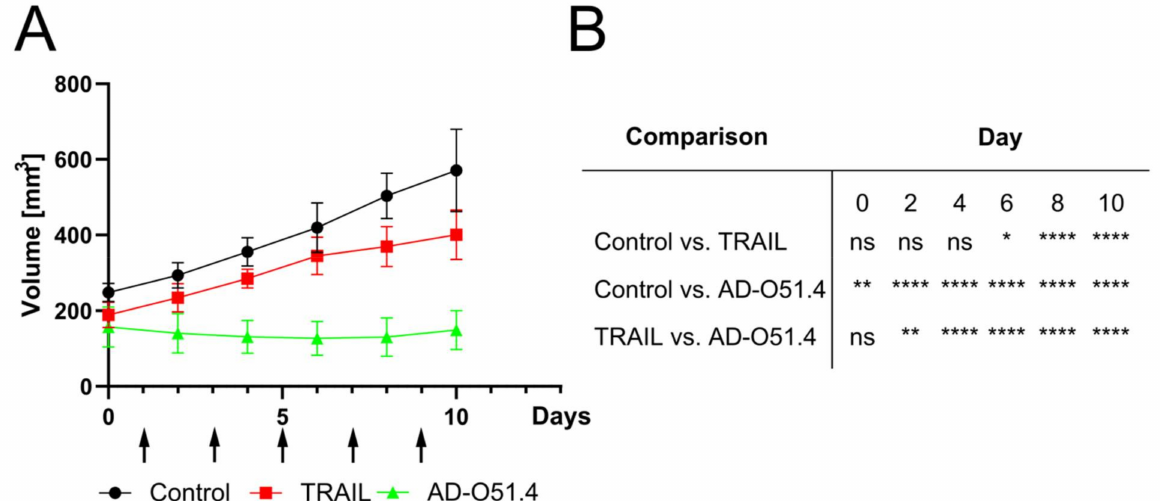
Figure 3. AD-O51.4 inhibits CACO-2 xenograft growth more efficiently than a native TRAIL protein. ( A ) AD-O51.4 and TRAIL were intravenously administered five times every other day (arrows) at 50 mg/kg. Groups size n = 6, each mouse bearing one tumor, ± SEM; ( B ) Statistical matrix showing differences between groups were evaluated using two-way repeated measures ANOVA; * p < 0.05, ** p < 0.01, **** p < 0.0001; ns: not